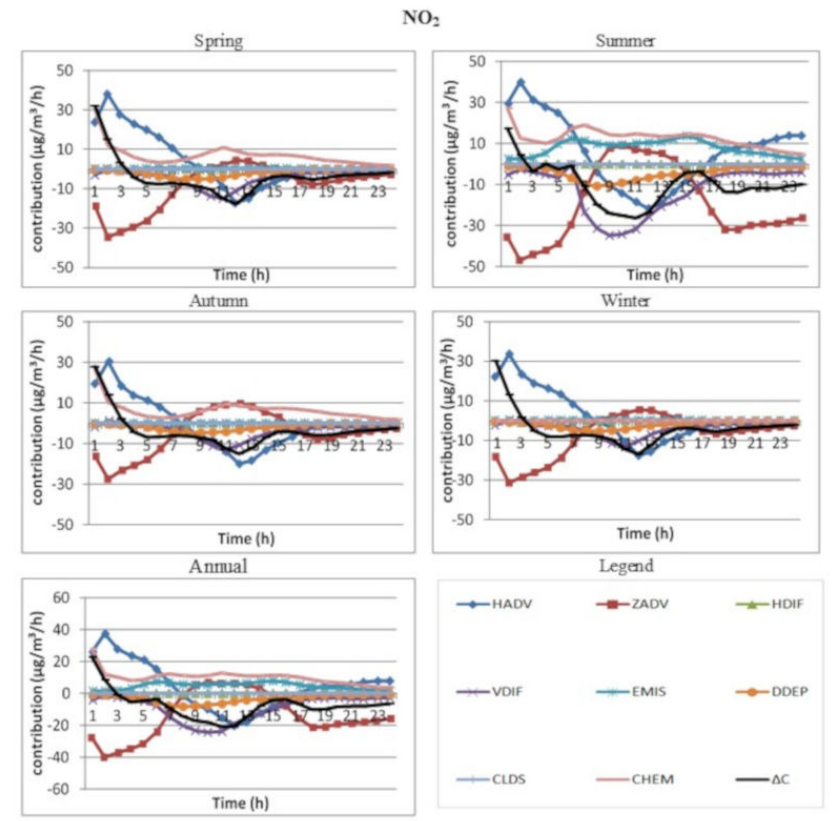
Figure 4. Annual, seasonal and diurnal course of the contribution of the different dynamic and chemical processes of the formation of NO 2 concentrations ( µ g/m 3 /h) averaged for the territory of Sofia for the period